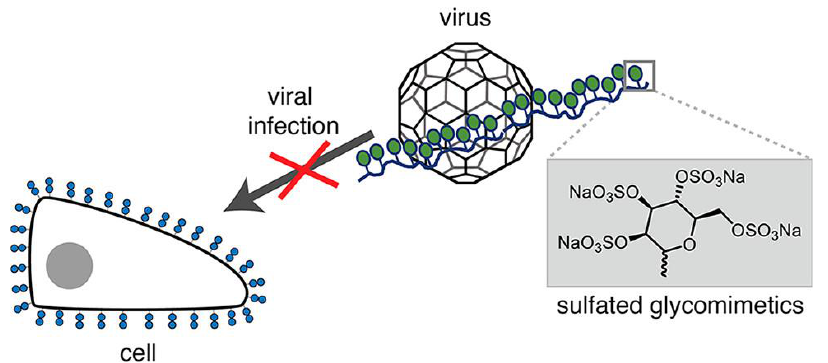
Figure 14. A model of competition between sulfate − like polymers and cellular glycans to inhibit virus invasion. Figure reproduced from ref. [66] with permission. virus invasion. Figure reproduced from ref. [66] with